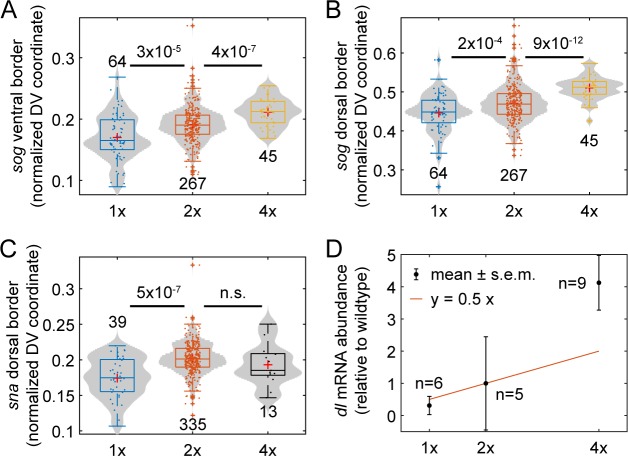
Varying the maternal dl dose influences gene expression.(A) Box-and-violin plot of the ventral border of sog. (B) Box-and-violin plot of the dorsal border of sog. (C) Box-and-violin plot of the of the dorsal border of sna. The numbers above or below distributions indicate sample size (numbers of embryos imaged). Numbers between distributions indicate p-value; n.s. = “not significant”. Plus signs indicate statistical outliers. (D) Abundance of dl mRNA relative to wildtype, measured by qPCR. Red curve indicates expectation of y = 0.5x. Circles indicate weighted mean and errorbars indicate weighted standard error of the mean (see Methods). Numbers indicate sample size, including both biological and technical replicates (see Methods).